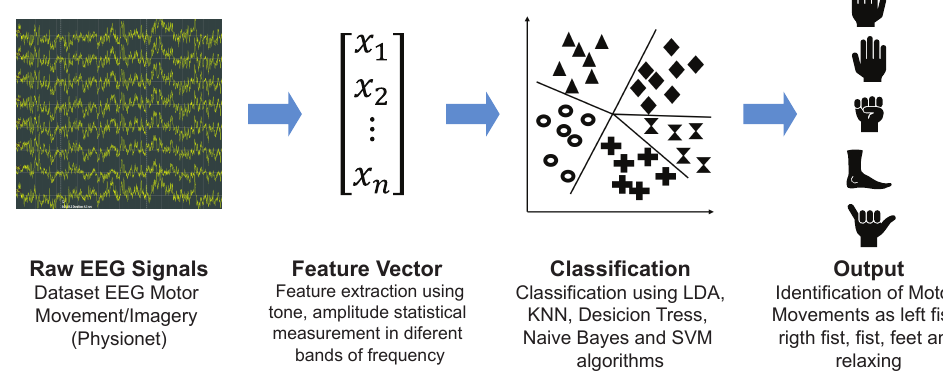
Figure 2. Proposed method for classifying EEG